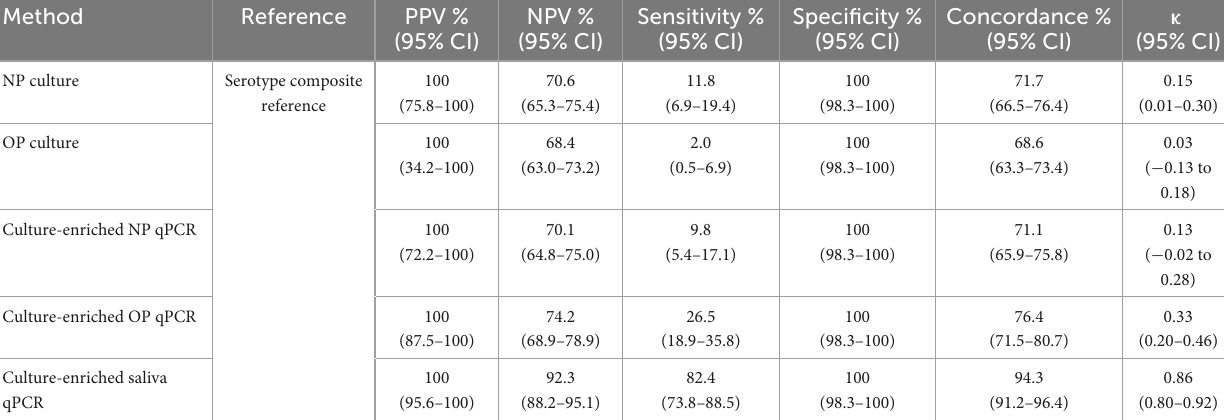
TABLE 5 The accuracy of Streptococcus pneumoniae serotypes detection in paired nasopharyngeal and saliva samples from n = 318 adults in the Netherlands tested using molecular methods applied to DNA extracted from culture-enriched samples and applying ROCd C q thresholds for sample positivity in